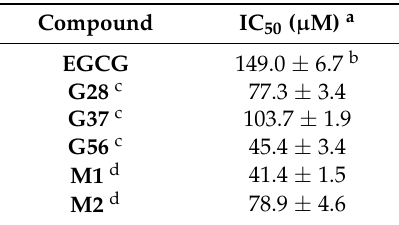
Table 1. Cytotoxicity in MDA-MB-231 cancer cells of diesters and monoesters.